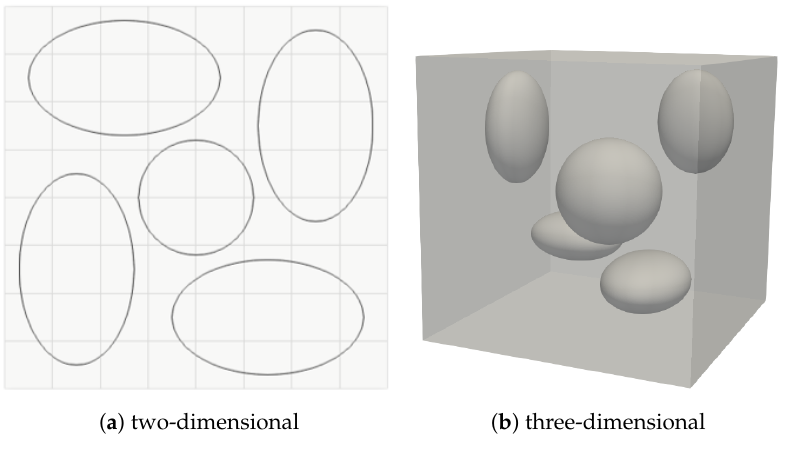
Figure 24. Unit cell with five ( a ) elliptical and ( b ) ellipsoidal inclusions.